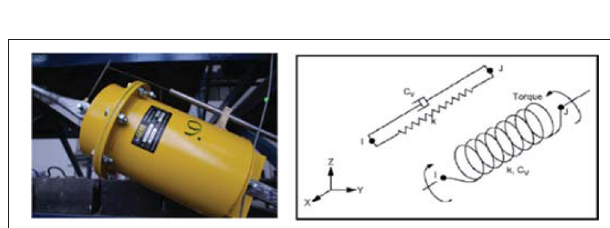
FIGURE 6 | Prototype and analytical model of the damper device